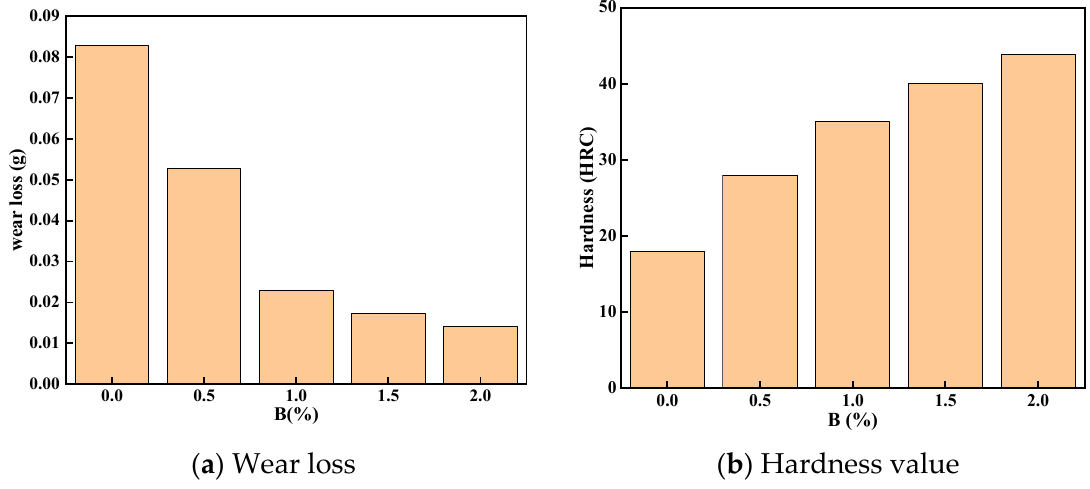
Figure 10. Wear loss and hardness value of surfacing layer with different amount of boron.